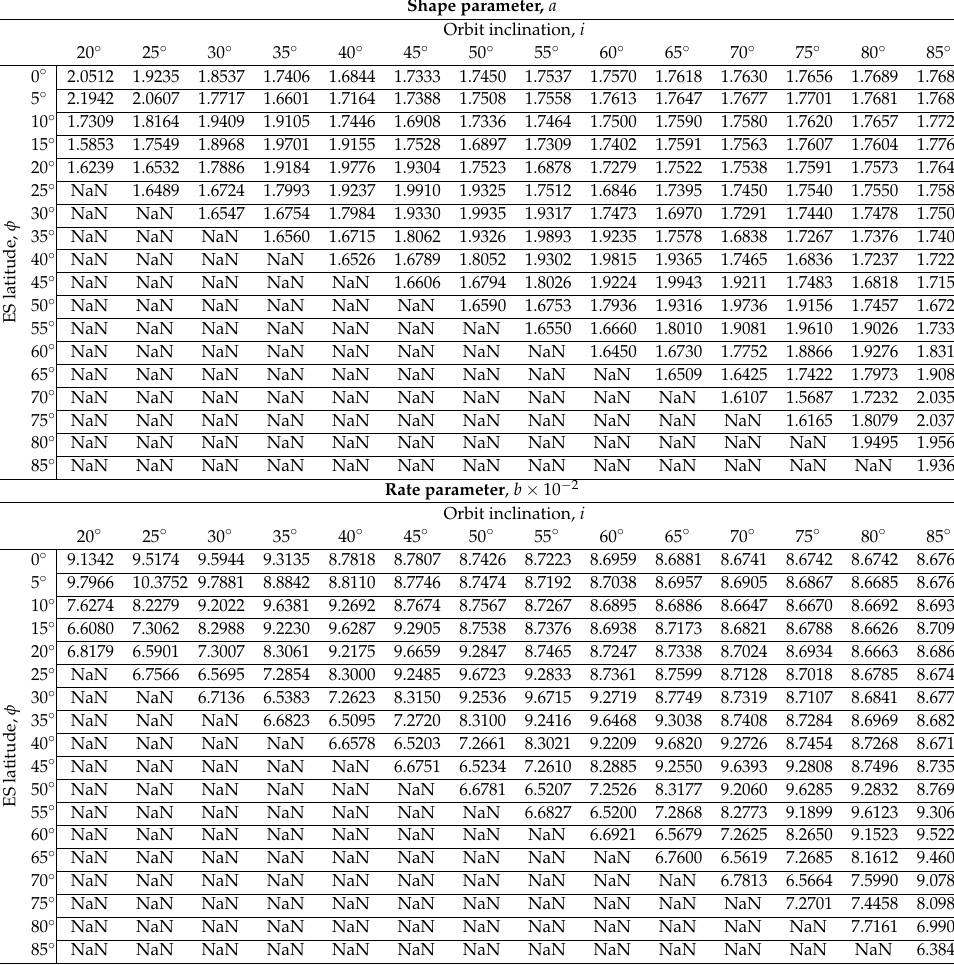
Table A4. Shape, a , and rate, b parameter for f Θ ( θ ) and F Θ ( θ ) for h k = 1600